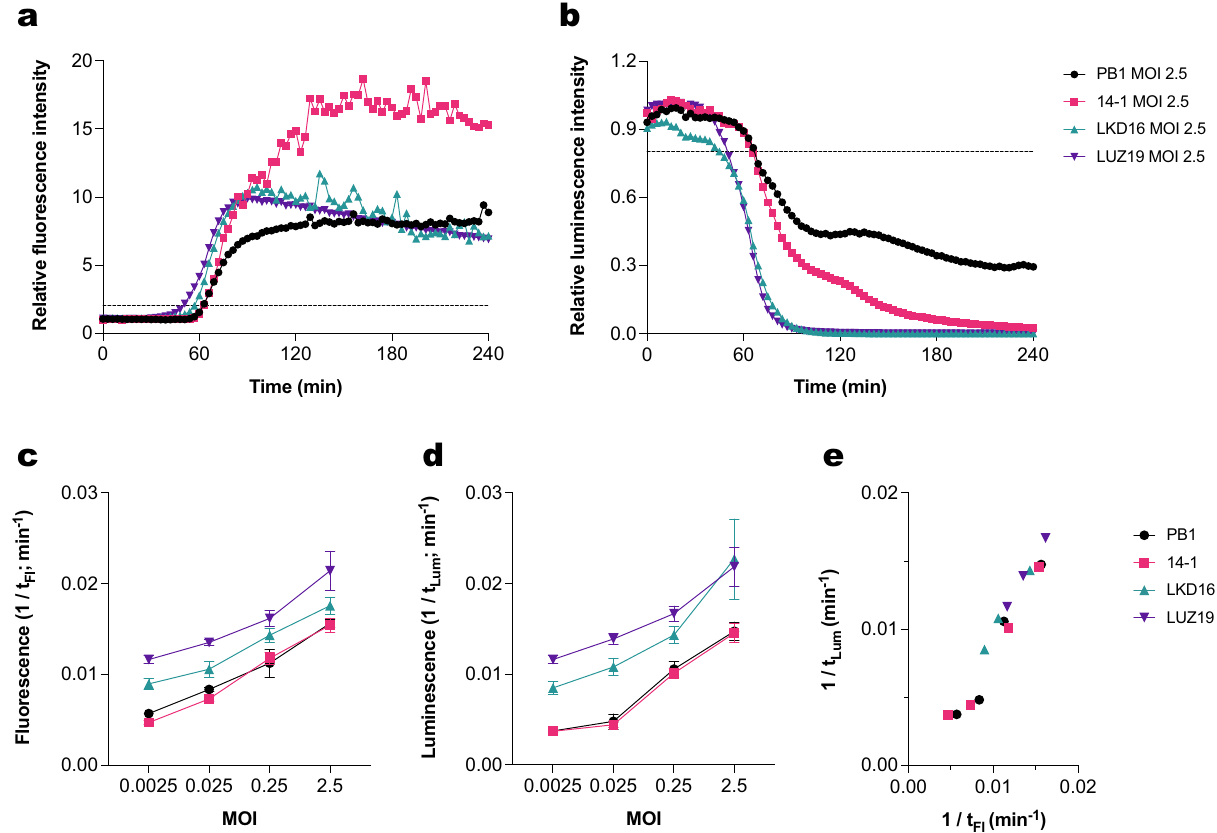
Figure 4. The fluorescent DNA dye assay correlates with bacterial metabolic activity for different Pseudomonas phages. PAO1 expressing a luciferase reporter system was incubated with phages PB1, 14–1, LKD16 and LUZ19 in a range of MOIs at 37 °C in the presence of Sytox green. ( a ) Sytox green fluorescence intensity was measured using a fluorometer. Values were divided by control signal to obtain relative fluorescence intensity. Black dotted line represents threshold for phage-mediated damage (relative fluorescence = 2). ( b ) Luminescence intensity of samples was measured and divided by signal of the control. Black dotted line represents threshold for phage- mediated damage (relative luminesence = 0.8). ( c ) Time of damage induction of the different phages as detected by the fluorescent DNA dye assay (t Fl ). Data are plotted as 1/t Fl and represent mean ± SD of three independent experiments. ( d ) Time of damage induction of the different phages as detected by luminescence measurements (t Lum ). Data are plotted as 1/t Lum and represent mean ± SD of three independent experiments. ( e ) Correlation between t Fl and t Lum for phages PB1, 14-1, LKD16 and LUZ19 at MOIs of 2.5, 0.25, 0.025 and 0.0025 (Pearson’s r = 0.97, two-tailed P value < 0.0001). Data represent mean of three independent experiments and are plotted as 1/t, where higher values indicate a faster infection. ( a , b ) A representative graph of at least three independent experiments is